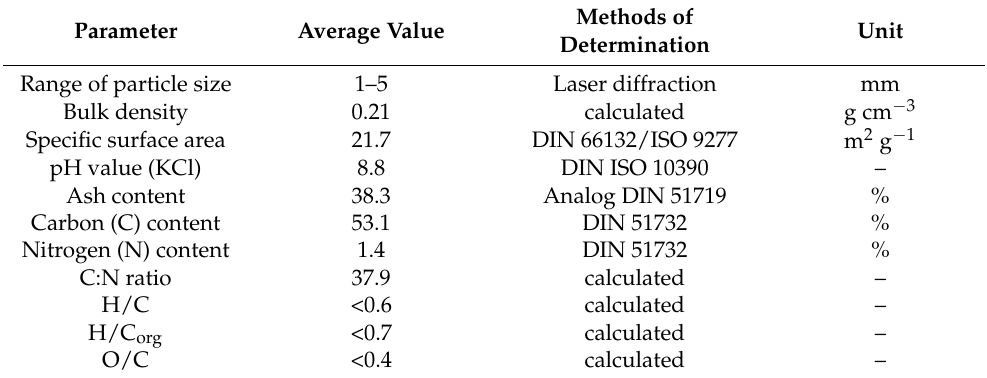
Table 2. Basic physical and chemical properties of the biochar used in the study (Certificate Nr.